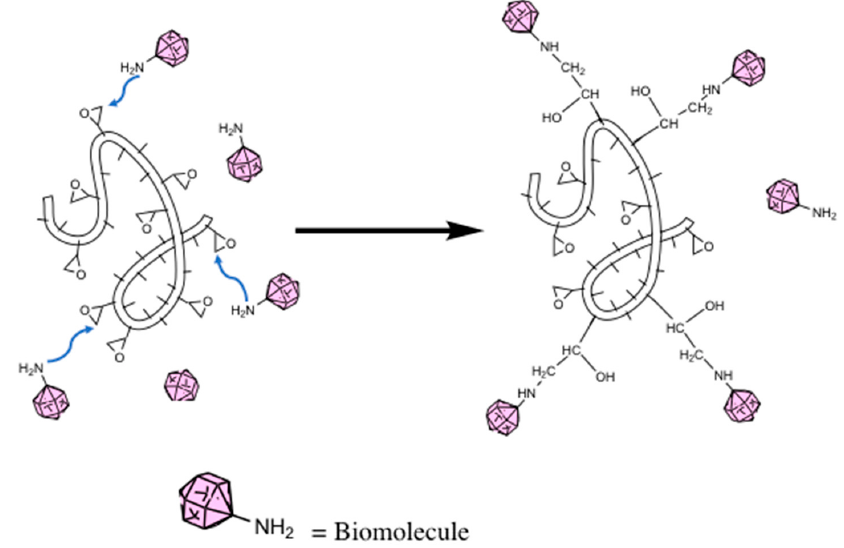
Figure 4. Schematic representation of epoxide ring opening mechanism for the covalent attachment of enzymes onto nanofibers.